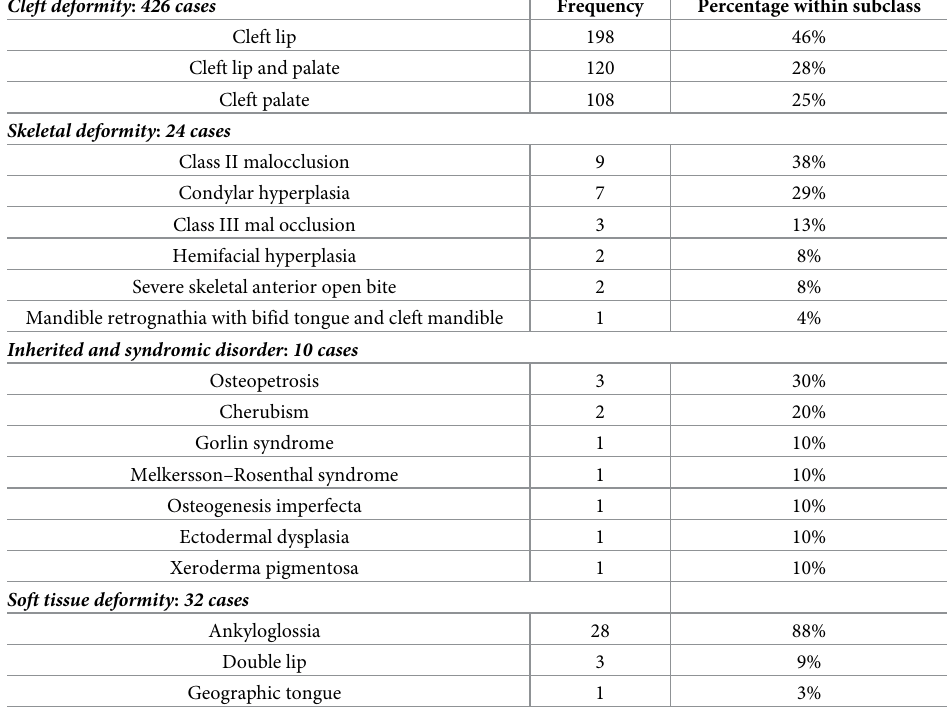
Table 6. Frequency of 492 developmental defects.